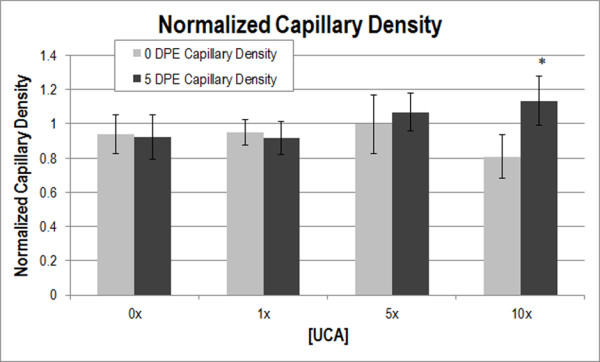
Normalized capillary density at 0 (light grey) and 5 (dark grey) DPE. * p < 0.05 with respect to 0 DPE at 10x [UCA]. The medial-site control value at 0 DPE and 5 DPE was 117.31 and 139.10 capillaries/mm2, respectively; these numbers were used for normalization.